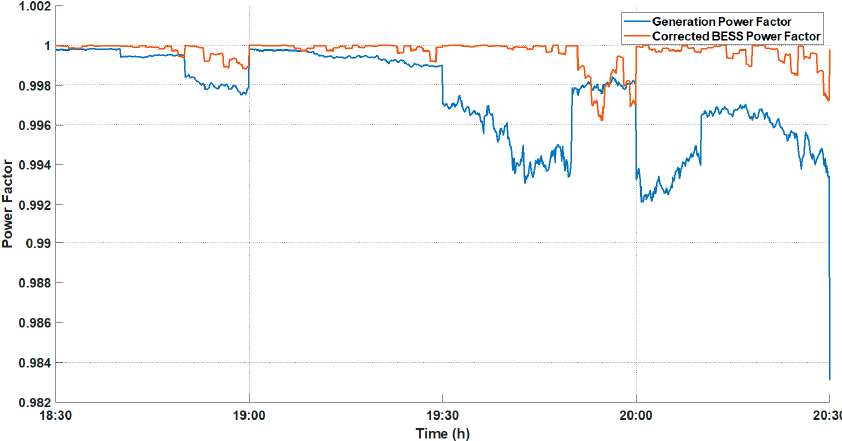
Figure 11. Power factor correction performed by BESS. Measurement performed on 20 April 2021.